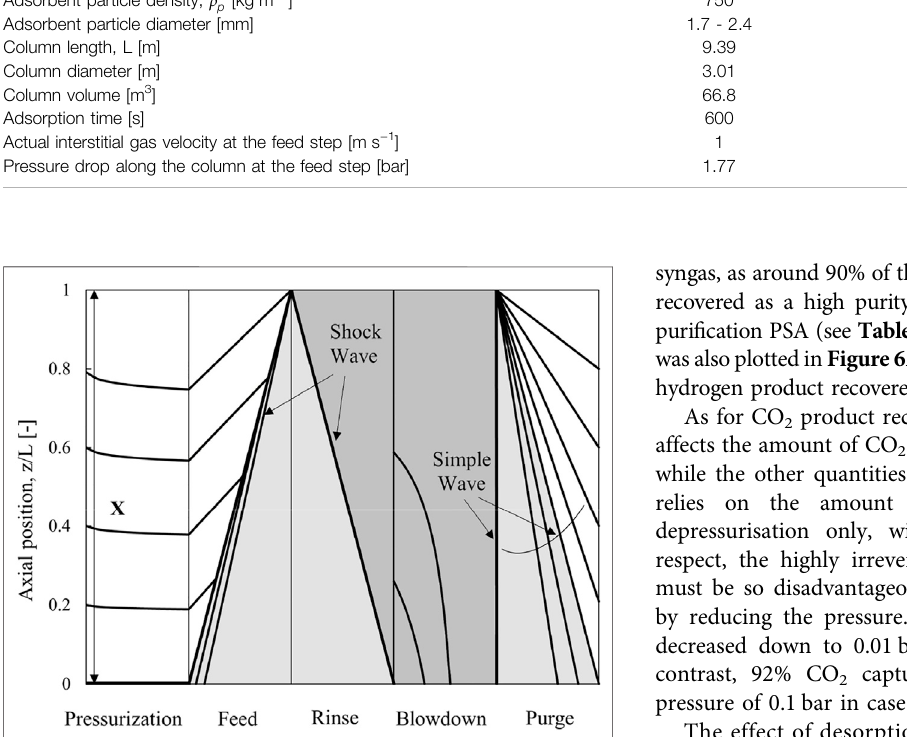
Frontiers in Chemical Engineering |